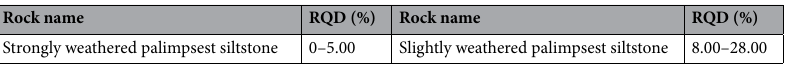
Table 3. Static of RQD.